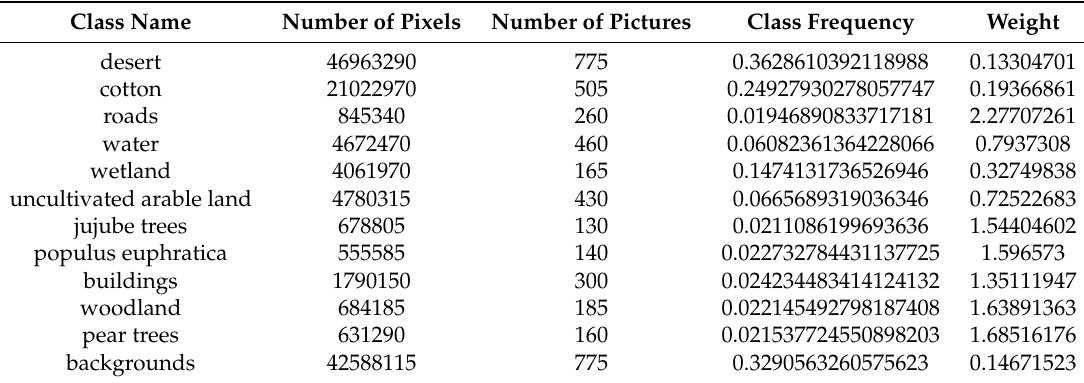
Table 2. Dataset sample